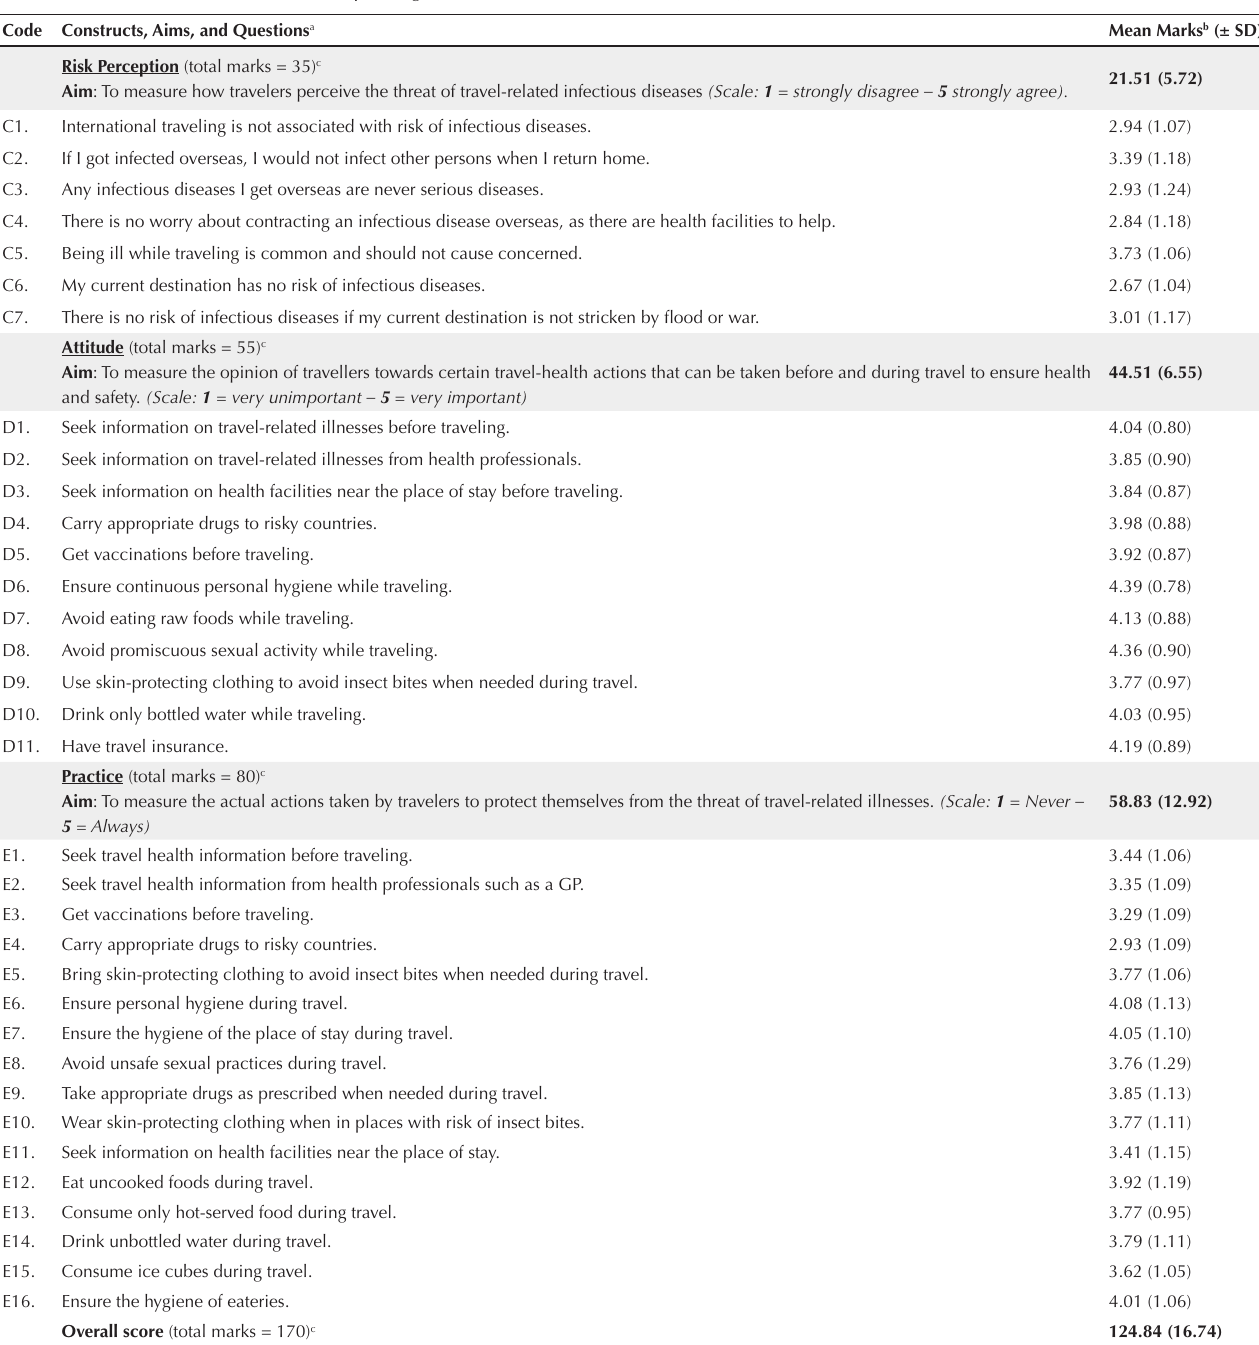
Table 1. Details of the Constructs and Corresponding Questions With Mean Marks of Each Question, Construct, and overall Score (N = 173) Code Constructs, Aims, and Questions